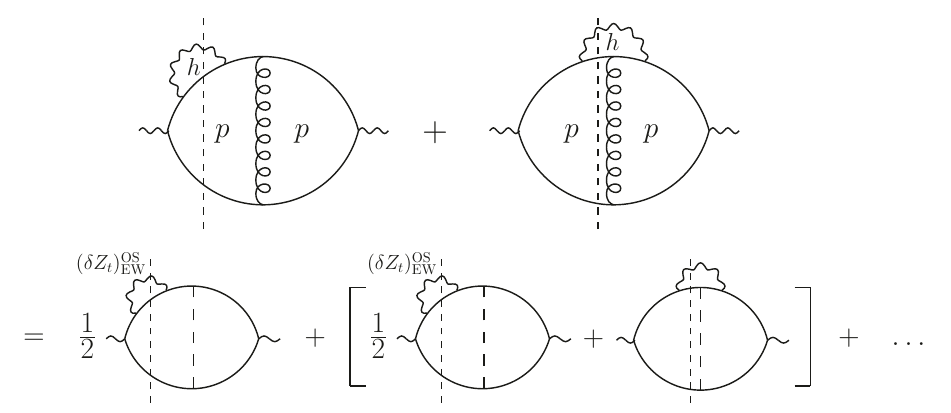
The NNLO resonant corrections related to h 1 a and h 1 b are given by the diagrams displayed in (cid:12)gure 19, where the loop-momenta in the top anti-top loops are expanded according to the potential ( p ) scaling, while the loop momentum in the bW loop is hard ( h ). It should be understood that in the diagram with the self-energy insertion in the propagator one has to consider only the NNLO piece (the cut self-energy in the on-shell limit gives the top-quark width, which is a LO contribution since p 2